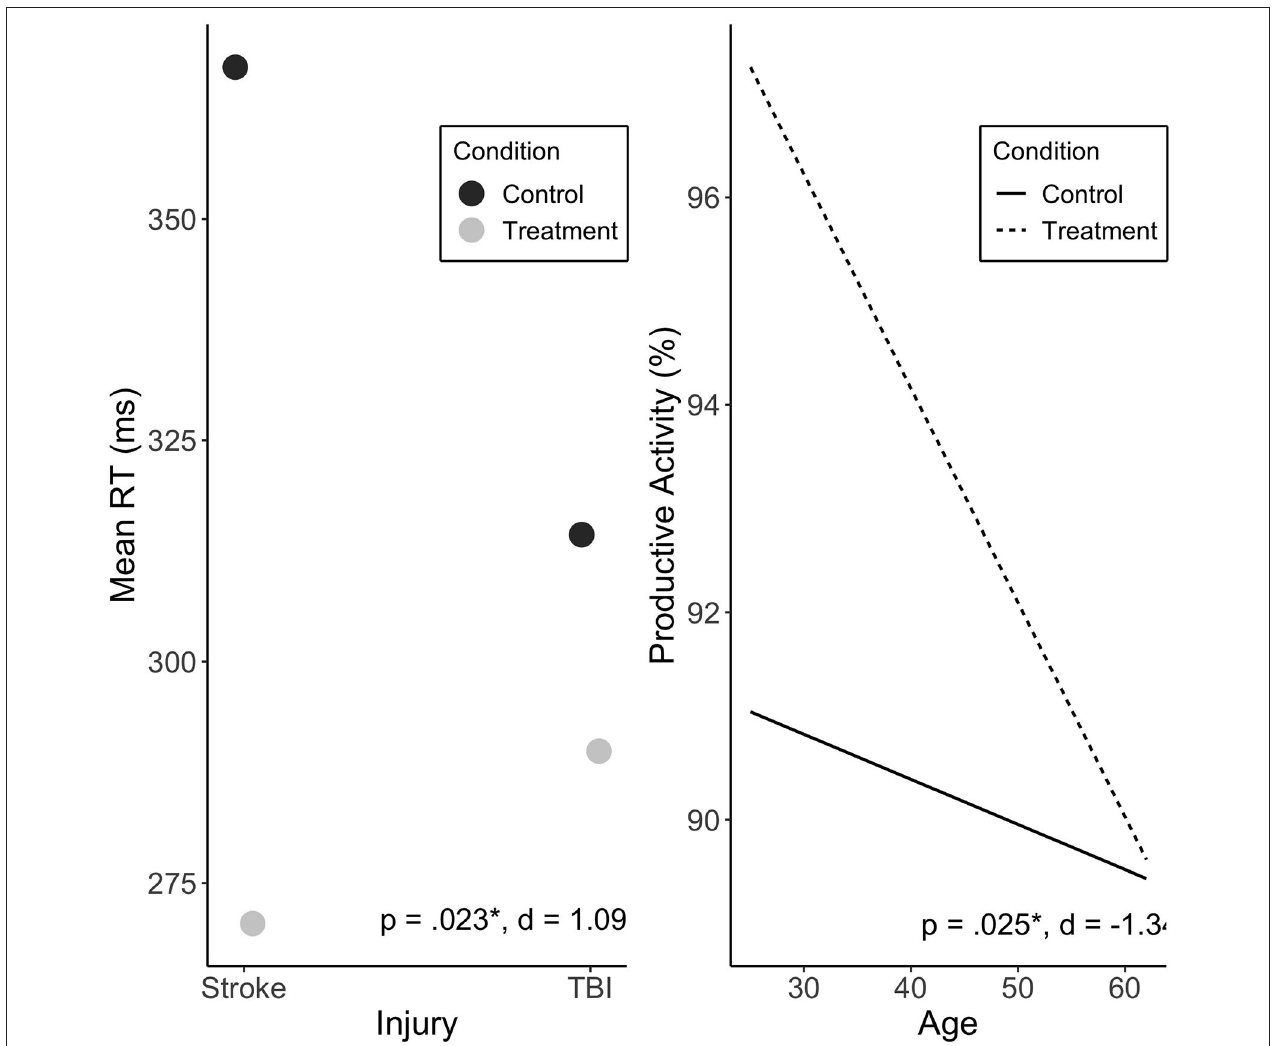
FIGURE 4 | Predicted values of mean RT (ms) by injury type (A) , and productive activity (%) by age (B) . Injury type significantly moderated treatment effect on mean RT, and showed large effect size. Age significantly moderated treatment effect on productive activity, with large effect. Treatment sequences are combined in figure. Significance ( p ) and effect size (Cohen’s d ) represented are for predictor-treatment